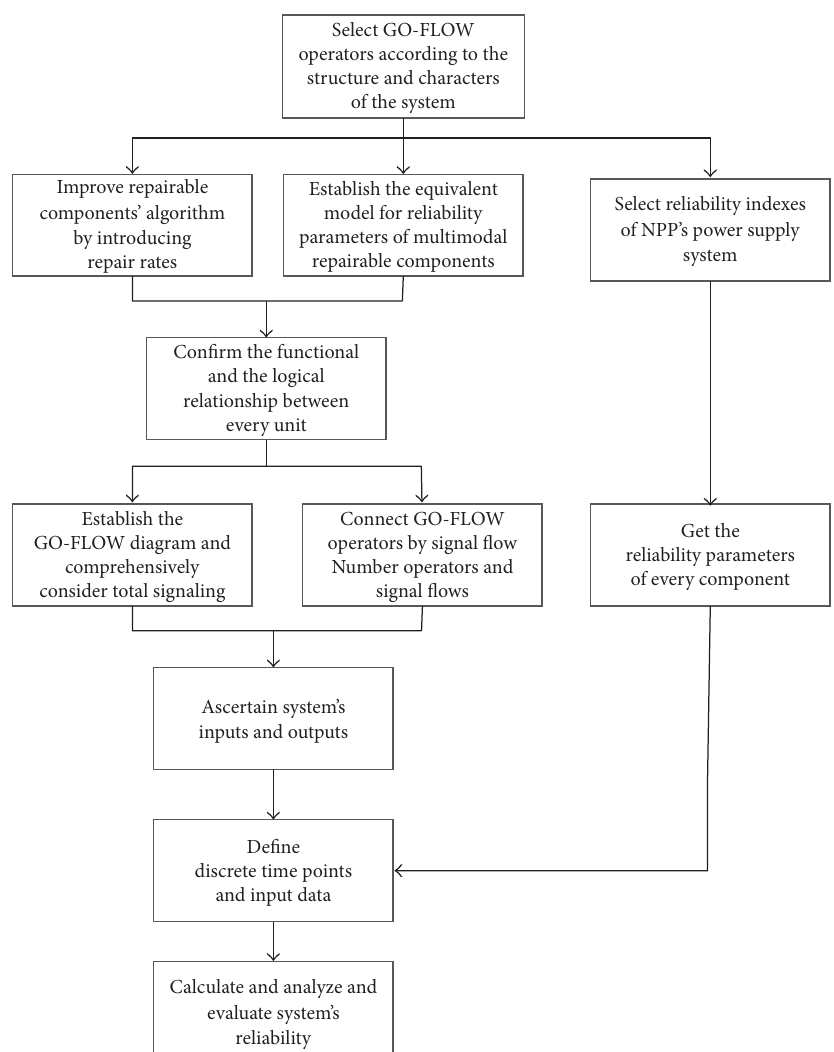
Figure 7: The GO-FLOW analysis process diagram of NPP’s power supply